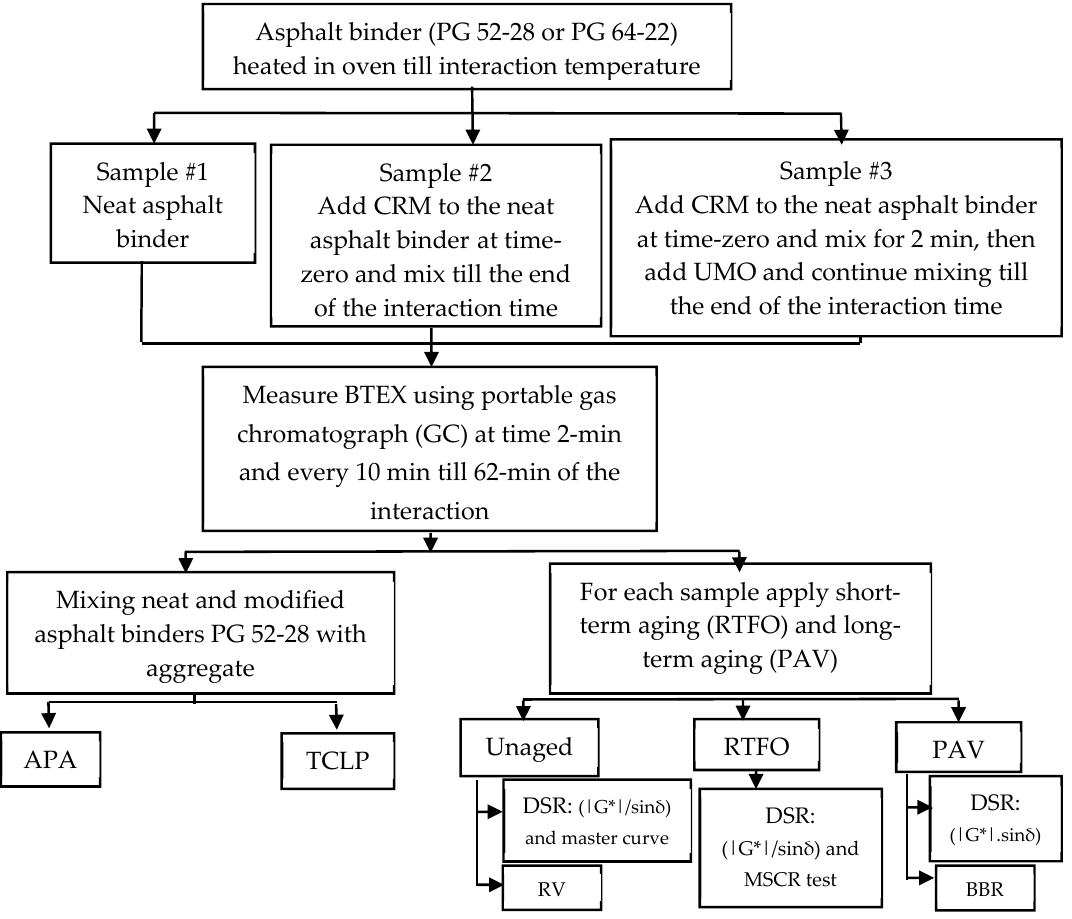
Figure 23. Experimental design.